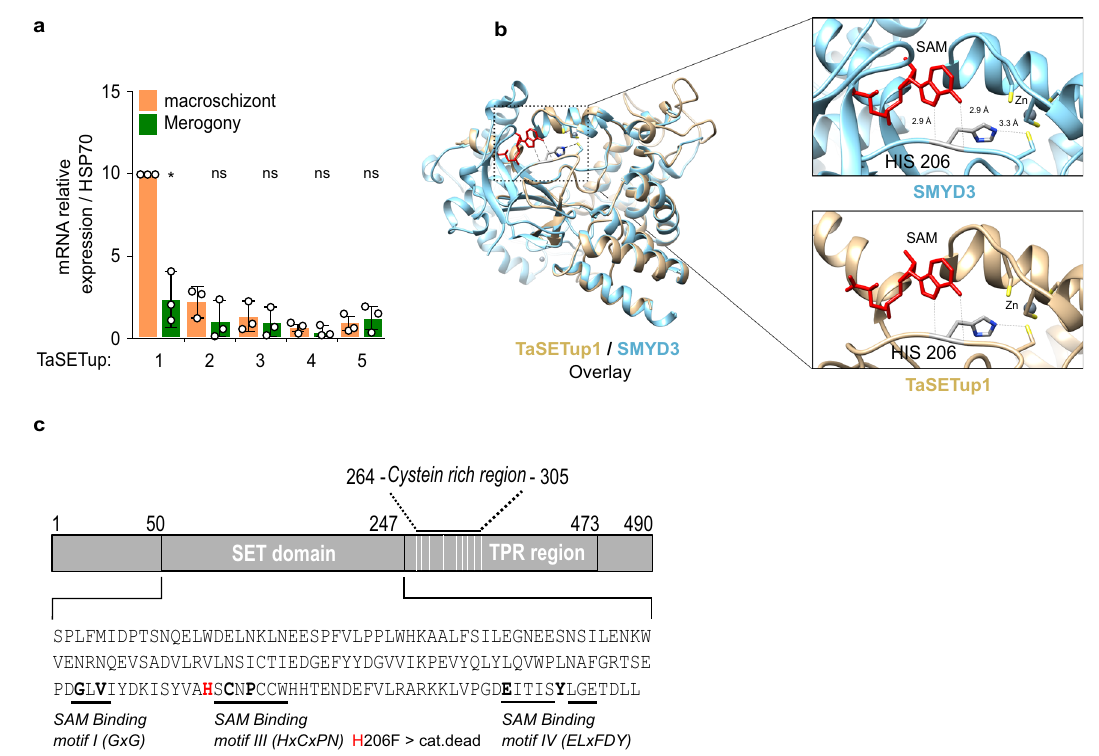
Fig. 6 The Theileria methyltransferase TaSETup1. a Analysis of expression (RT-qPCR) the TaSETup genes in macroschizont or merogony culture conditions (37 or 41 °C, respectively). Results were normalized to TaSETup1 at 37 °C and represent three independent experiments ( n = 3). Statistical test Dunnett ’ s multiple comparison two-sided tests showing changes upon merogony: ns = not statistically signi fi cant > 0.6389; * p = 0.0488. b Comparison of TaSETup1 predicted structure (beige) with the crystal structure of the human SMYD3 protein (blue, PDB ID: 6IJL), with zoom window of the active site highlighting TaSETup1 H206 residue (red). c Schematic of the TaSETup1 protein, highlighting the SAM binding regions and the H206 residue